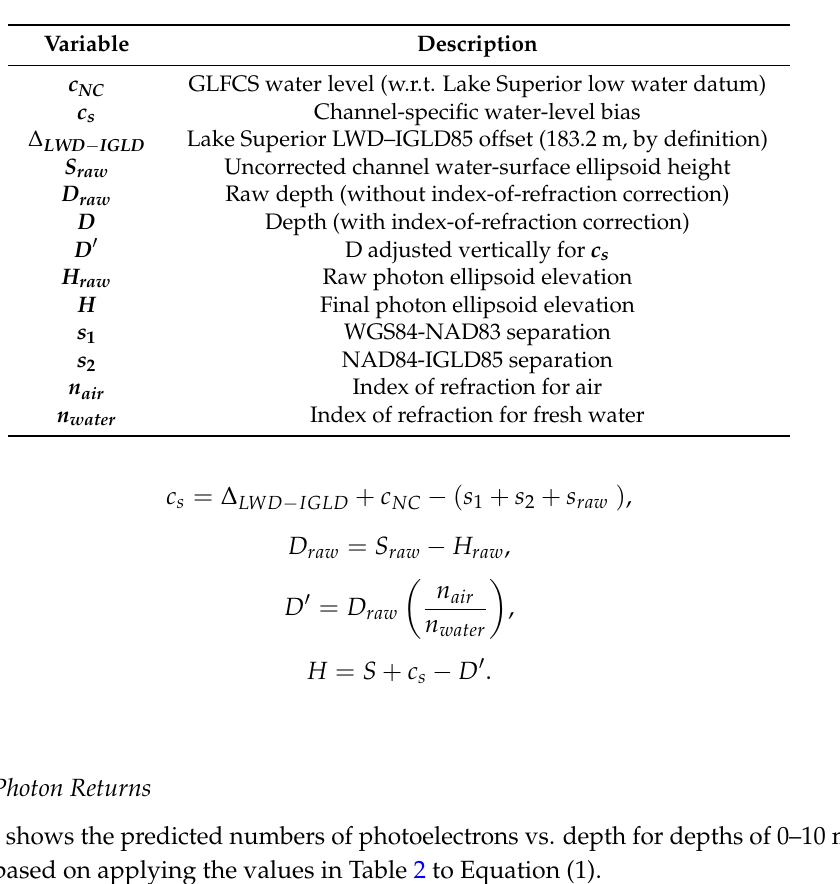
Table 3. Values used to reduce raw bottom elevations to WGS84 (G1674) elevations corrected for index-of-refraction and channel-specific water level biases.